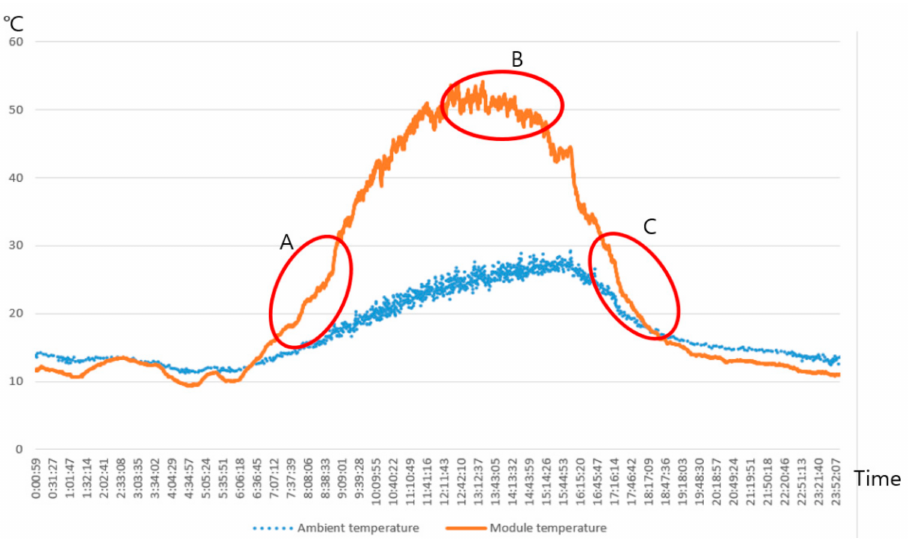
Figure 4. Graph of ambient and module temperatures (10 May